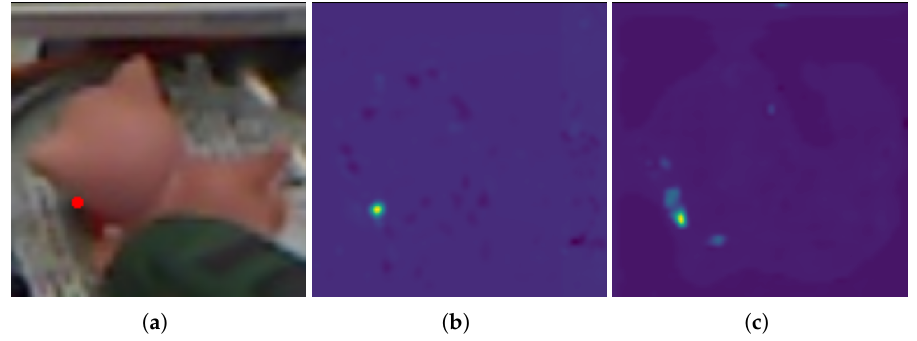
Figure 7. Predicted heatmap using HWing Loss and MSE Loss. ( a ) occluded object and keypoint; ( b ) heatmap using HWing Loss; ( c ) heatmap using MSE